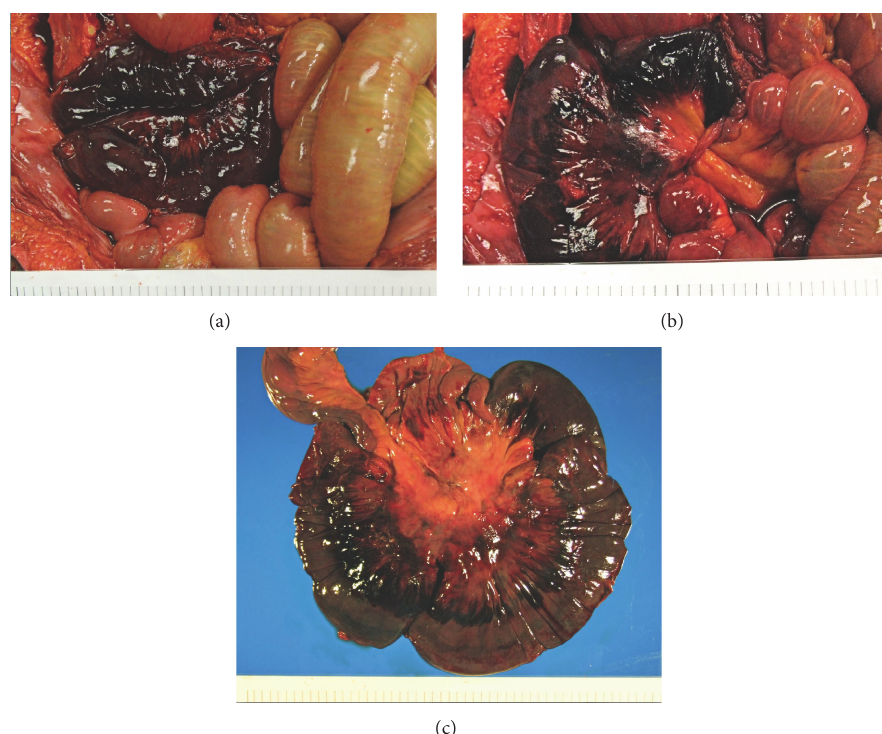
Figure 1: (a) Sixty-centimeter segment of necrotic jejunum secondary to volvulus. (b) Note the band of elastic tissue causing tissue strangulation and necrosis. (c) Necrotic segment of bowel with transmural